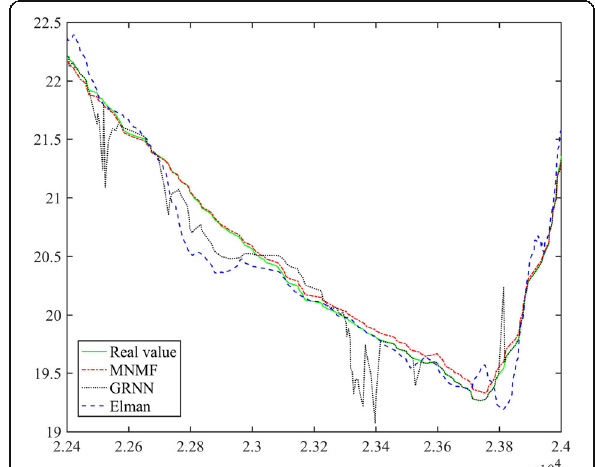
Fig. 12 Diagram of prediction